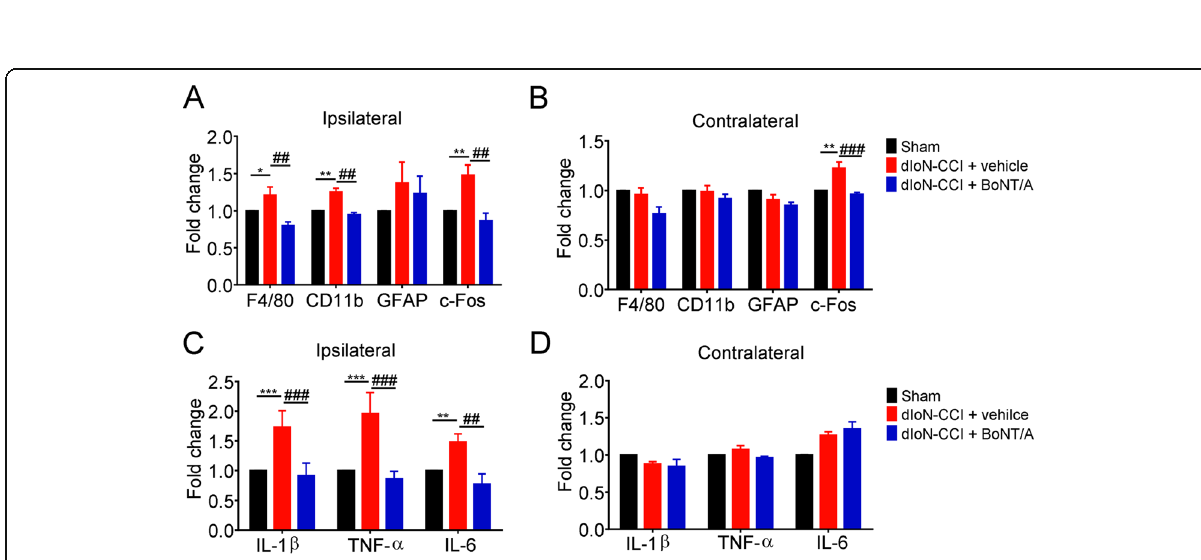
Fig. 6 The expression of glia activation markers and proinflammatory factors in bilateral TNC site using RT-qPCR. a On the ipsilateral TNC of dIoN- CCI surgery, the mRNA expression of F4/80, CD11b and c-FOS were significantly increased by dIoN-CCI surgery, and BoNT/A treatment significantly decreased their up-regulation. b On the contralateral TNC of dIoN-CCI surgery, only the mRNA expression of c-FOS was increased by dIoN-CCI surgery, and BoNT/A treatment significantly decreased the up-regulation of c-FOS. c On the ipsilateral TNC of dIoN-CCI surgery, the mRNA expression of pro-inflammatory factors IL-1 β , TNF- α and IL-6 were significantly elevated by dIoN-CCI surgery, and BoNT/A treatment significantly decreased their up-regulation. d There was no statistically significant difference in the expression of proinflammatory factors on the contralateral TNC of dIoN-CCI surgery. Data was expressed as Mean ± SEM. ( n = 4 each group, * P < 0.05, ** P < 0.01, *** P < 0.001 compared with the sham group. ## P < 0.01, ### P < 0.001 compared with the dIoN-CCI group, unpaired Student ’ s t-test). TNC, Trigeminal nucleus caudalis; dIoN- CCI, Chronic constriction injury of distal infraorbital nerve; BoNT/A, Botulinum toxin